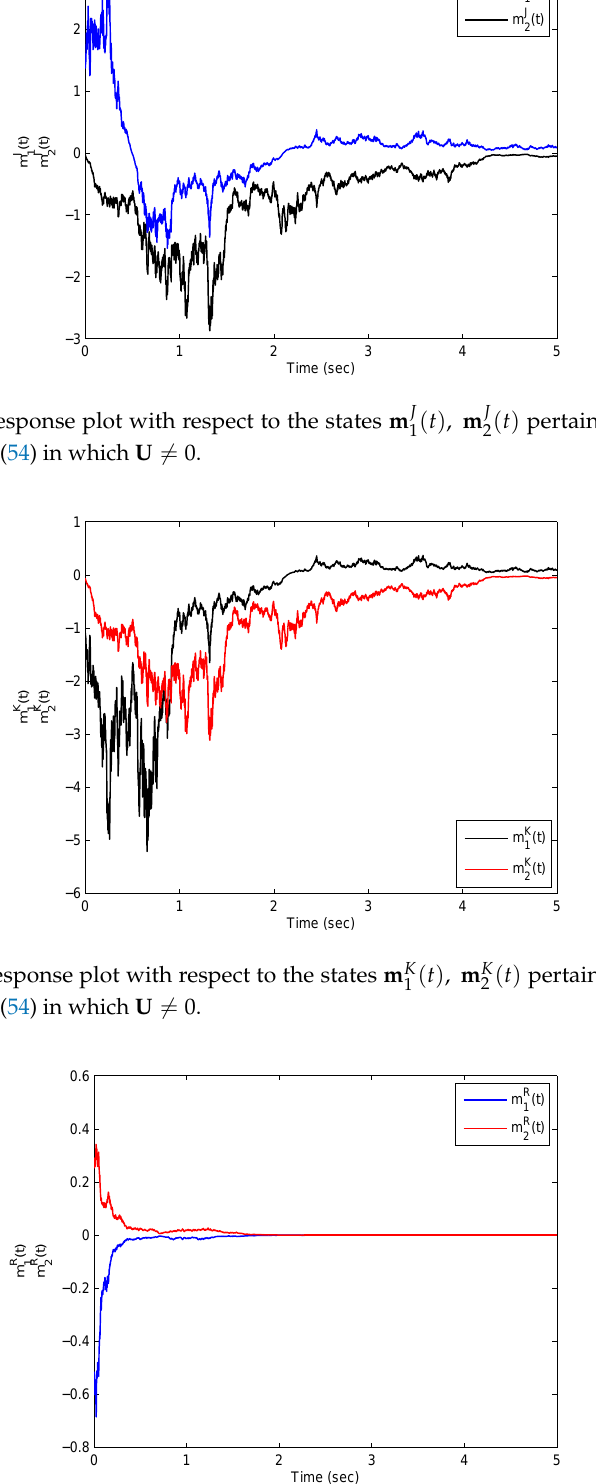
Figure 5. A time response plot with respect to the states m R model in Equation (54) in which U =